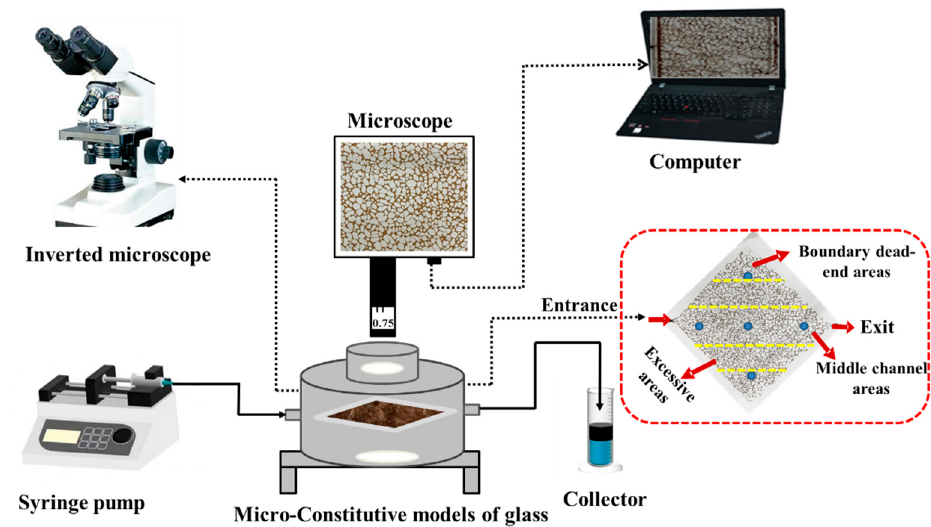
Figure 1. Schematic diagram of residual oil-displacement experimental equipment process by mi- cromodels.